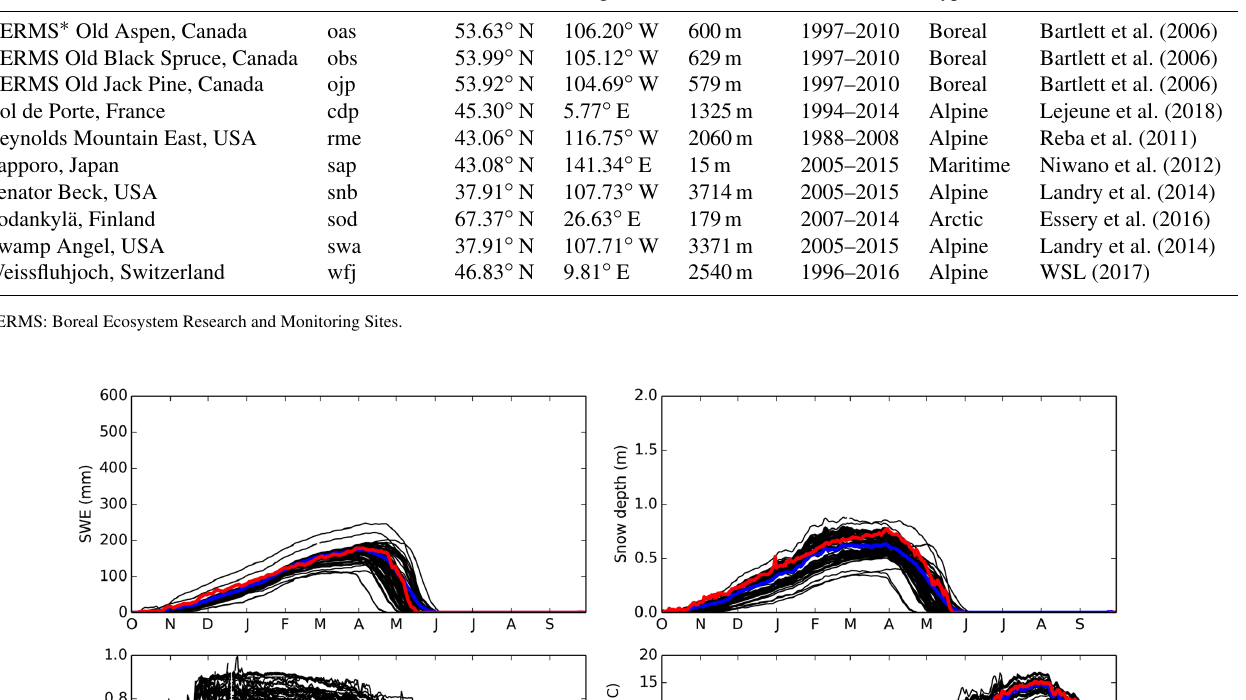
Table 3. ESM-SnowMIP reference sites with abbreviations used in Fig. 4. Site